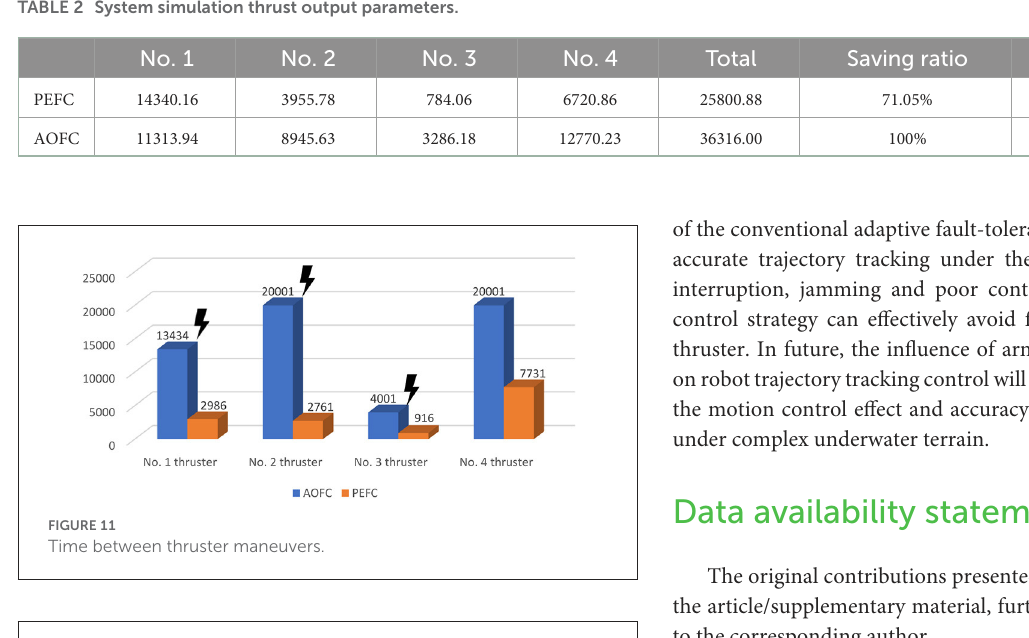
TABLE 2 System simulation thrust output parameters.